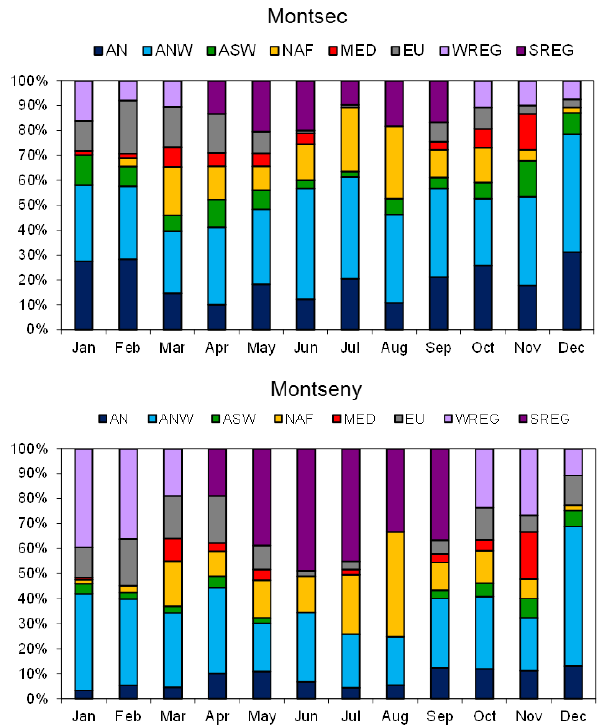
Figure 1. Average frequency of air mass origin at Montsec and Montseny for the different months based on daily calculations be- tween January 2010 and March